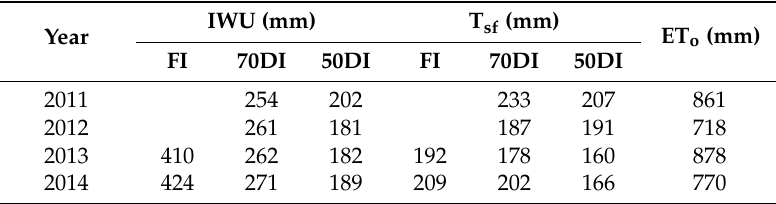
Table 3. Summary of seasonal irrigation water use (IWU), sap flow transpiration (T sf ), and reference evapotranspiration (ET o ) recorded values for full irrigation (FI), 70% deficit irrigation (70DI), and 50% deficit irrigation (50DI) regimes applied to olive orchards from 2011 to 2014.